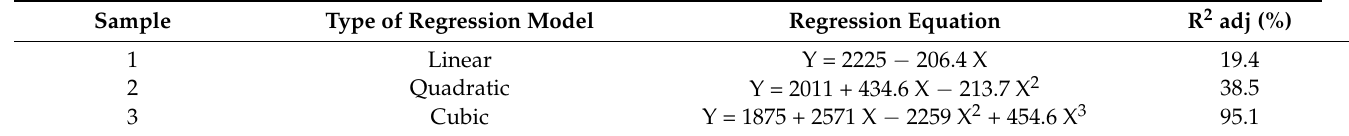
Table 11. The orthogonal polynomial regression model for the mortar flexural modulus with the addition of 3% OPS-activated charcoal and EFB hydrochar.